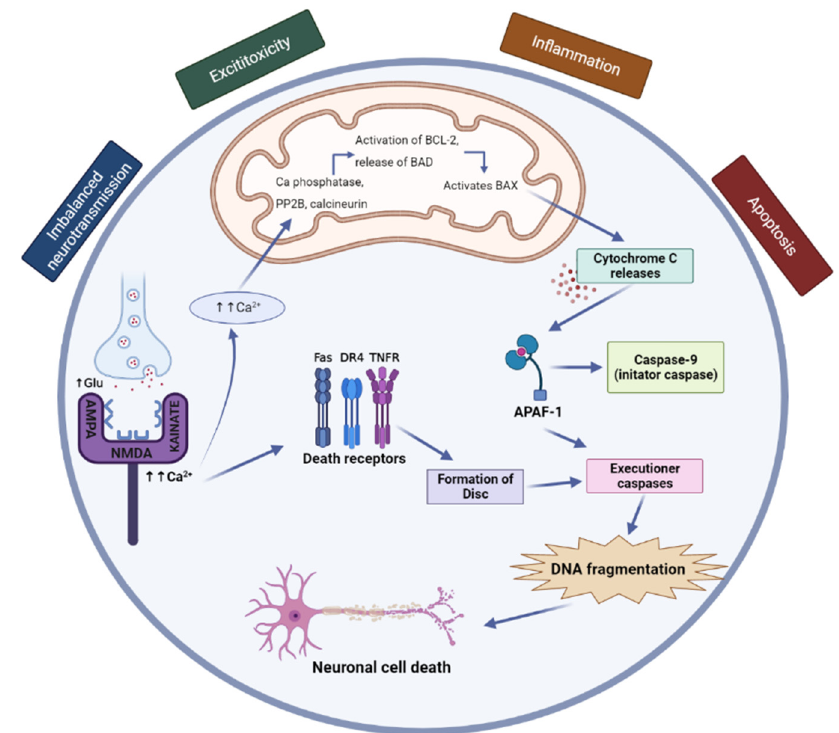
Figure 1. The pathophysiology of epilepsy (adapted from [35]). In the brain, glutamate serves as the main excitatory neurotransmitter, whereas GABA serves as the main inhibitory neurotransmitter. For the nervous system to operate normally, glutamatergic and GABAergic tone must be balanced. When glutamate is released in a large amount, it can cause excitotoxicity, which results in neuronal damage, cell death, and dysfunction in the remaining neurons after brain injury. These glutamates cause an increased influx of Ca 2+ ions by overactivating NMDA receptors. By activating cytoplasmic proteases, which break down cytoskeletal and other proteins, neuronal nitric oxide synthase (nNOS), which increases nitric oxide production, and peroxynitrite, which damages DNA, the overflow of Ca 2+ levels causes deteriorated conditions that ultimately lead to neuronal cell death. (https://link.springer.com/article/10.1007/s11910-015-0545-1 “accessed on 20 July 2022”).